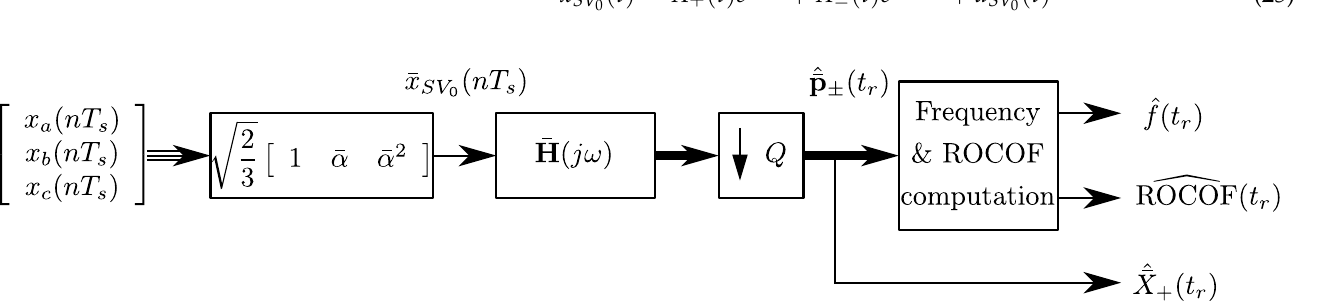
Figure 3. Block diagram of the SV-TF